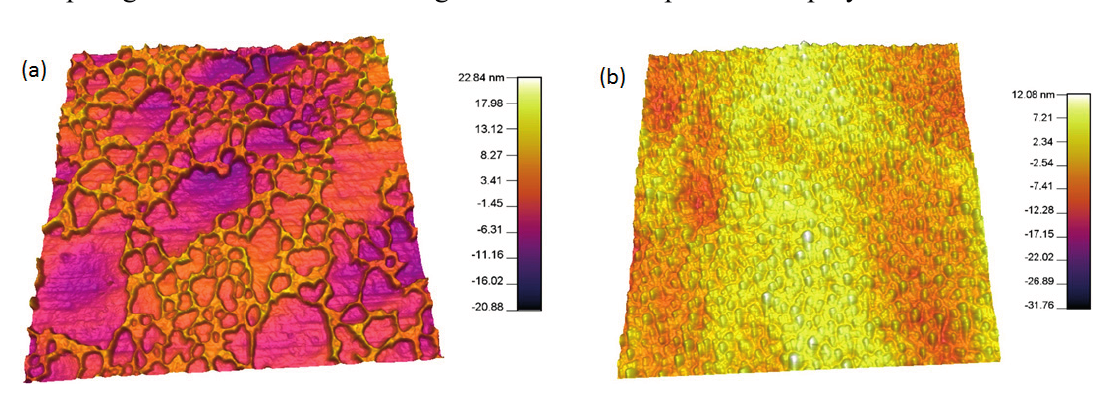
Figure 8. ( a ) Representative 3D Tapping mode AFM scans of untreated PEEK + BSA showing the how the BSA is adsorbed on a hydrophobic polymer surface; ( b ) plasma treated PEEK + BSA showing the how the BSA is adsorbed on a surface modified polymer surface.